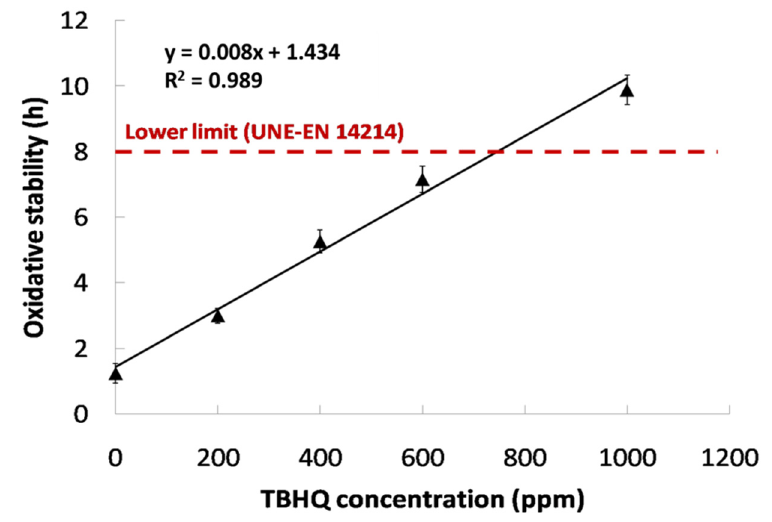
Figure 6. Effect of tert-butylhydroquinone (TBHQ) addition on oxidative stability and concentration optimization.